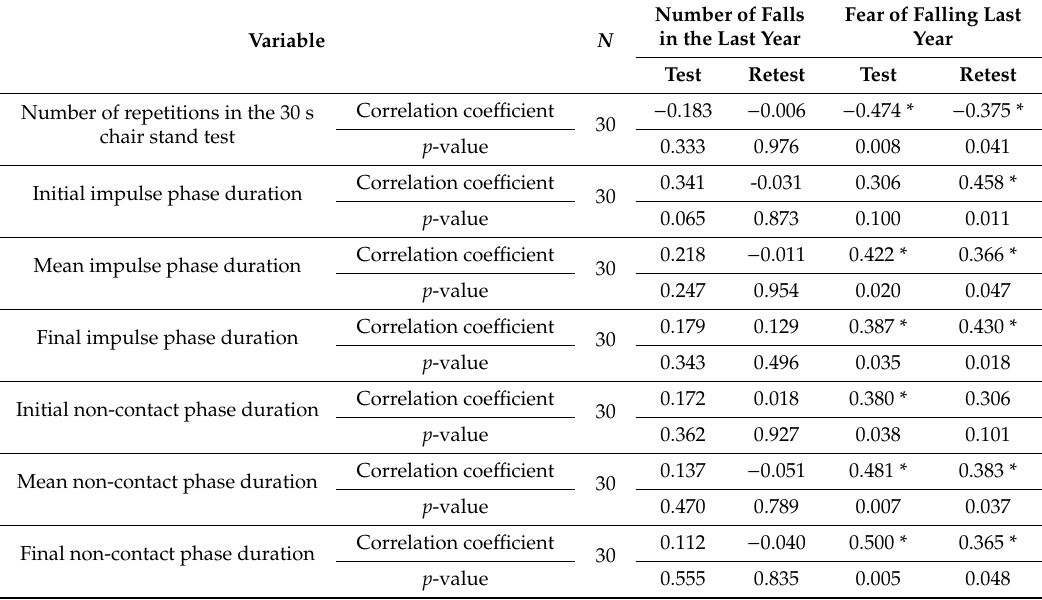
Table 5. Relationship between fear of falling, number of falls, and other variables related to phases of movement in the 30 s chair stand